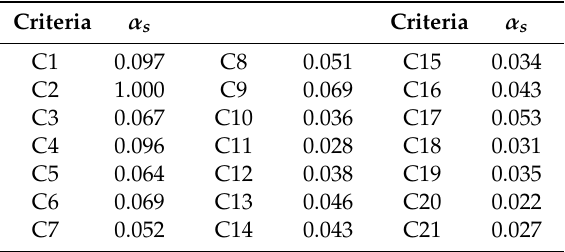
Table 6. Coe ffi cient of elasticity for changing